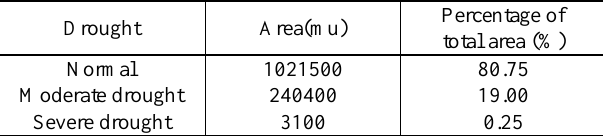
Table 3. Drought monitoring area and percentage of total irrigation area to total